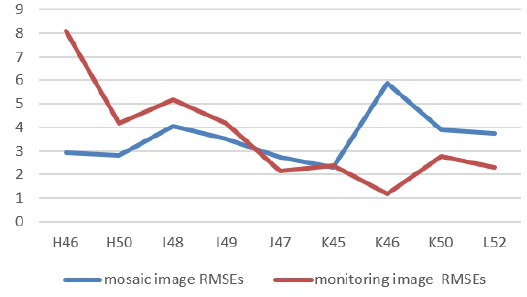
Figure 2. Image accuracy analysis